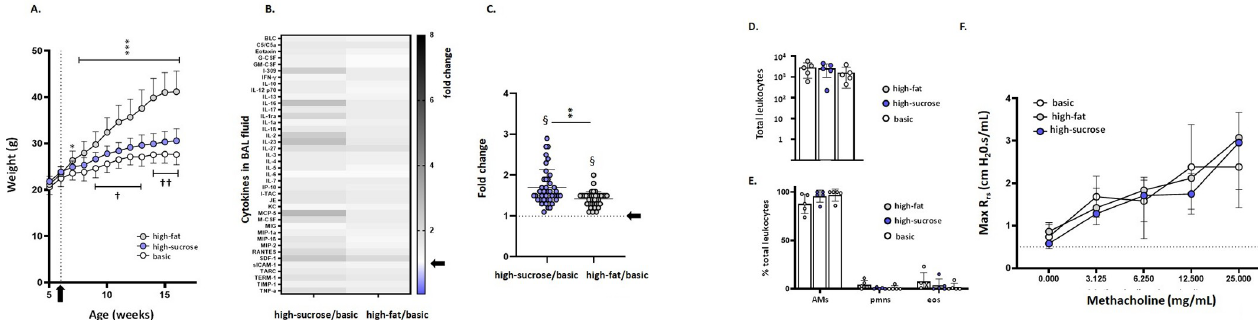
Fig 1. An isocaloric high-sucrose diet results in weight gain and modest elevations in proinflammatory cytokines in the airways. (A) Male C57BL/6 mice were maintained on basic (10% fat, 3.82 kcal/g), isocaloric/high sucrose (10% fat; 3.82 kcal/g with 33.6 g sucrose/g), or high-caloric/high-fat (60% fat, 5.21 kcal/ g) diets (from Research Diets, Inc.; see S1 Table for full details) for 10 weeks, beginning at 6 weeks of age (at the arrow and vertical dotted line). Body weights ( ± standard deviation [SD], in grams) are as indicated; n = 18–20 mice per group, � p < 0.05, ��� p < 0.001, high-fat vs . basic diet; † p < 0.05, †† p < 0.01, high- sucrose vs . basic diet, 2-way ANOVA with Dunnett’s post hoc test. (B) Heatmap and ( C ) semiquantitative analysis of cytokine profiles in bronchoalveolar lavage (BAL) fluid. The data shown are ratios of signals detected in BAL fluid of mice maintained on a high-sucrose or high-fat diets, each normalized to signals from BAL fluid of mice maintained on the basic diet and presented as fold-increase, n = 5 mice as described in the Methods. Arrows indicate no increase over signal detected in mice on basic diet (fold change = 1.0). Mean and SD for all cytokines are as shown in (C) at 1.7 ± 0.44 (high-sucrose/basic) and 1.4 ± 0.18 (high fat/basic); �� p < 0.01 (high-sucrose/basic vs . high-fat/basic, Mann-Whitney U-test); § p < 0.001 vs . theoretical mean (= 1.0), one-sample t-tests. (D) Total leukocytes and (E) leukocyte differentials (% alveolar macrophages [AMs], neutrophils [pmns], and eosinophils [eos]) in BAL fluid of mice maintained on high-sucrose, high-fat, and basic diets. ( F ) Airway resistance (R rs ; cmH 2 O.s/mL) observed in response to increasing concentrations of methacholine (0–25 mg/ mL) in mice maintained on basic, high-sucrose, or high-fat diets (n = 5 mice per group). No statistically significant differences were